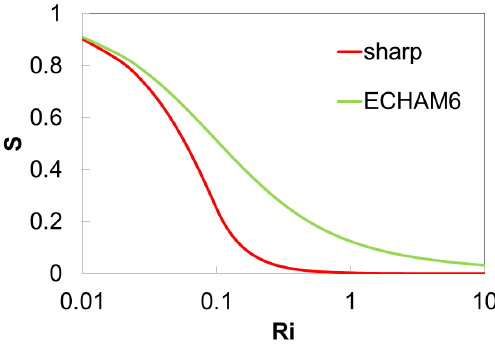
Figure 1. Comparison of “sharp” and ECHAM6 stability function S (Eq. 4, dimensionless) as a function of Richardson number